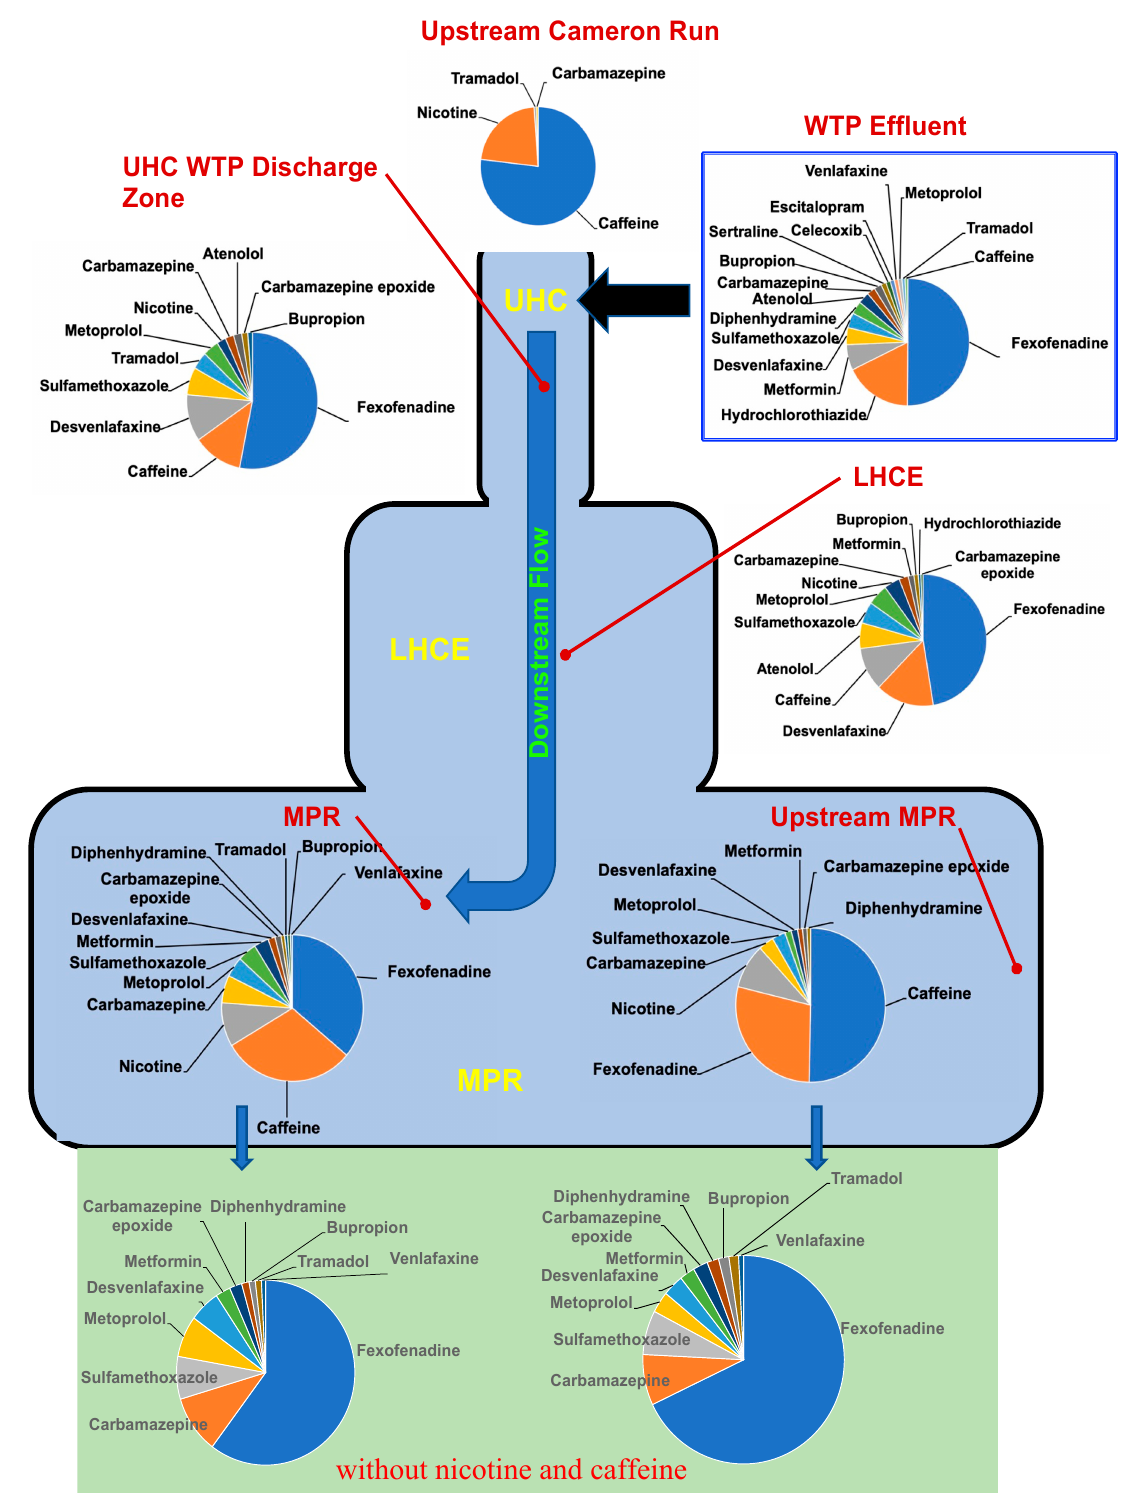
Figure 2. PPCP composition (% derived from ng/L) along downstream flow path of Cameron Run/Hunting Creek watershed into the tidal freshwater Potomac River. Bar charts represent 99% composition by mass. The black arrow denotes the outfall discharge point of WTP 2. (UHC, Upper Hunting Creek; LHCE, Lower Hunting Creek embayment; MPR, mainstem Potomac River.) Green shaded pie charts reflect composition comparisons without nicotine and caffeine included.